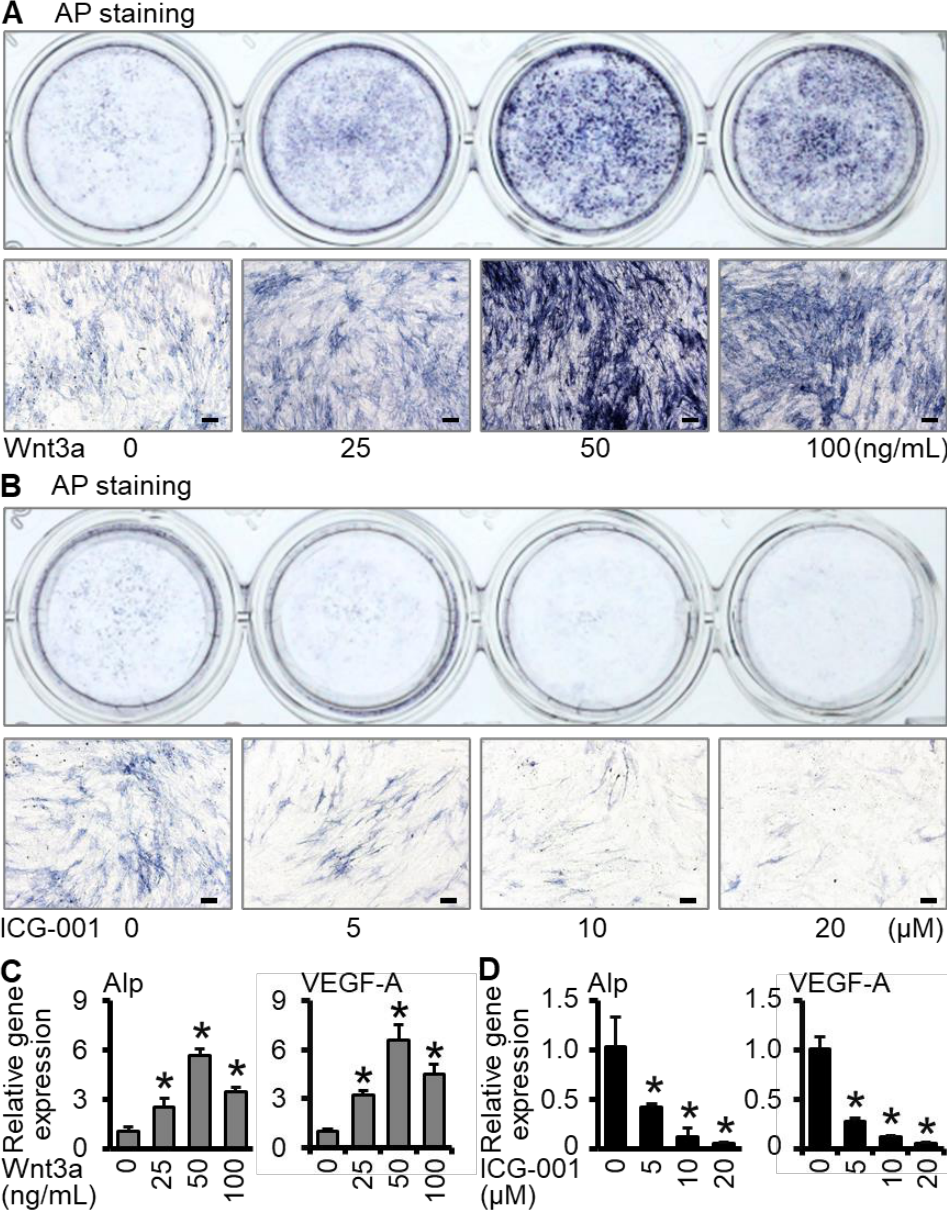
Figure 1. Screening of appropriate concentration of Wnt3a to promote osteogenic differentiation of ST2 cells. Under two-dimensional conditions, ST2 cells were induced by Wnt3a or ICG-001 (Wnt/ β - catenin signaling inhibitor) for 24 h. AP staining and quantitative real-time polymerase chain reaction (qRT-PCR) detection were performed on the seventh day. ( A , B ) Alkaline phosphatase staining. ( C , D ) qRT-PCR detection of the expression of osteogenic differentiation gene Alp, angiogenesis factor VEGF-A. * p < 0.05, compared with Wnt3a 0 ng/mL or ICG-001 0 µ M group by one-way ANOVA (n = 3). (Scale bars: A, 100 µ m, B, 100 µ